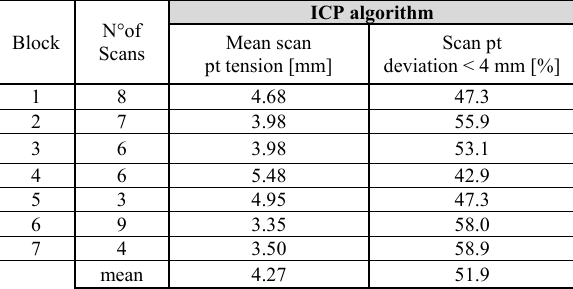
Table 5. Accuracy results based on ICP algorithm